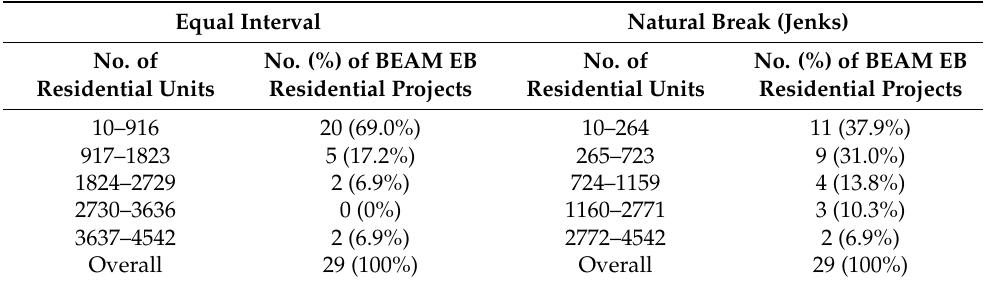
Table 6. Number of residential units of BEAM-certified projects for residential uses (N = 29). Equal Interval Natural Break (Jenks) No. of